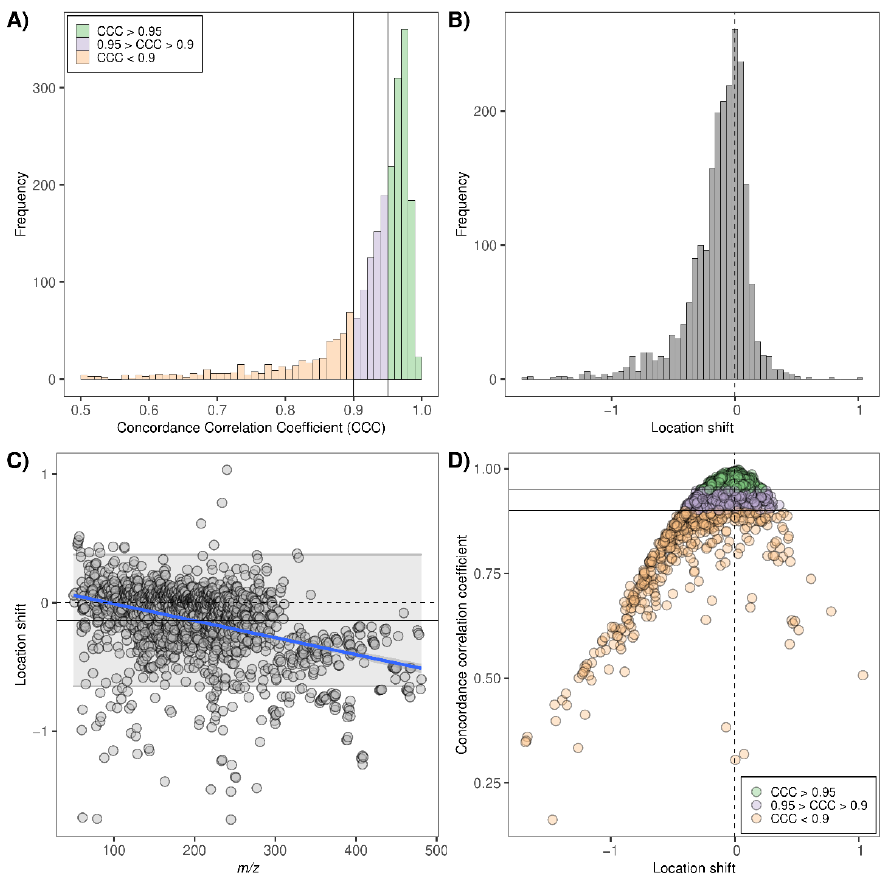
Figure 1. ( A ) Histogram of the CCCs calculated for all exhaled breath features. For visualization purposes and due to their lower frequency, CCC values below 0.5 were excluded from the plot. Two vertical lines represent CCC cut-offs 0.95 and 0.9. Green: CCC > 0.95; purple: 0.95 > CCC > 0.9; orange CCC < 0.9. ( B ) Histogram of the location shifts of all exhaled breath features. Vertical dashed line: location shift = 0. ( C ) Scatter plot of location shifts as a function of m/z . Horizontal dashed line: location shift = 0. Gray ribbon: 95% confidence band. Gray horizontal line: average location shift over all features. Blue line: simple linear regression capturing the trend of the location shift as a function of m/z . ( D ) Scatter plot of CCC as a function of the location shift for all exhaled features. Coloring and horizontal lines indicate CCC ranges as in plot ( A ). Vertical dashed line: location shift = 0.